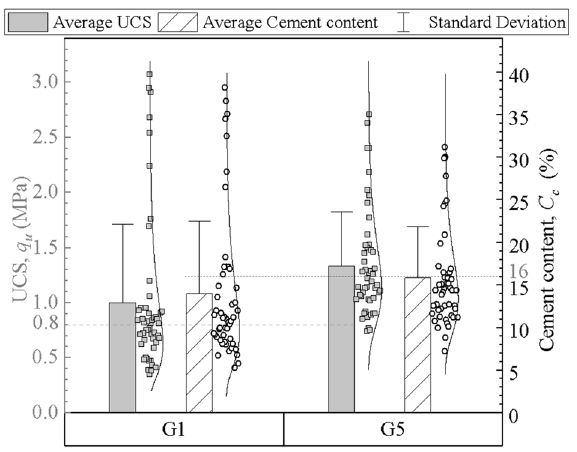
Figure 11. Cement content and UCS of the columns of groups #G1 and #G5.